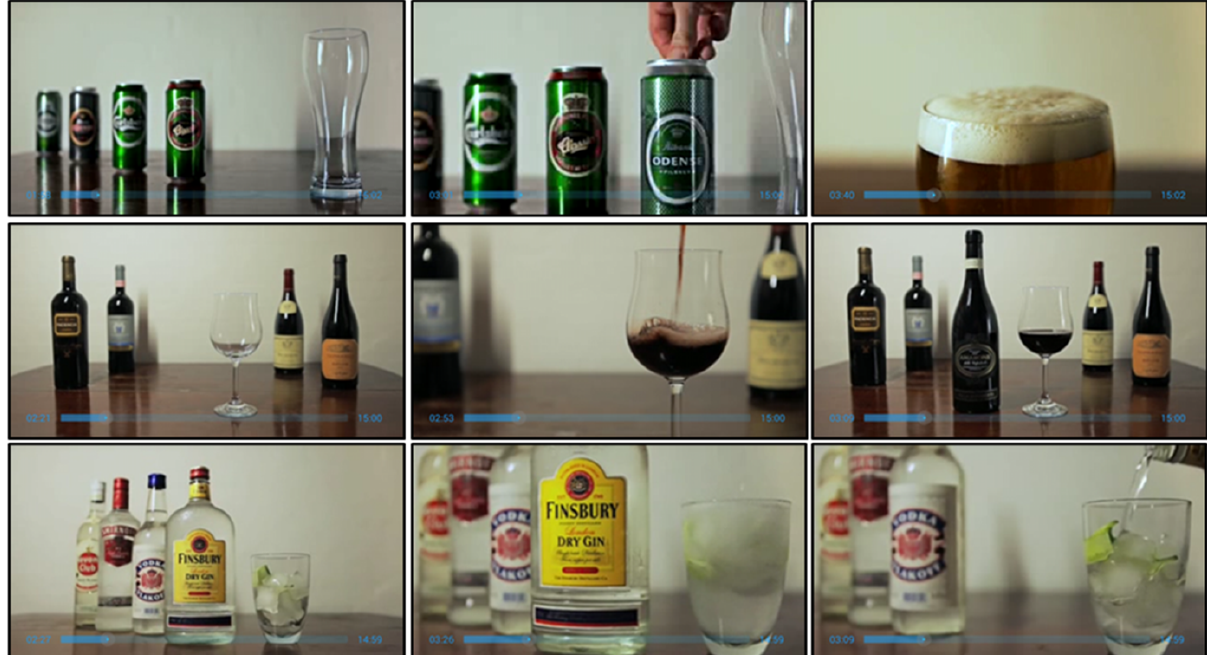
Figure 4. Examples of the alcohol exposure